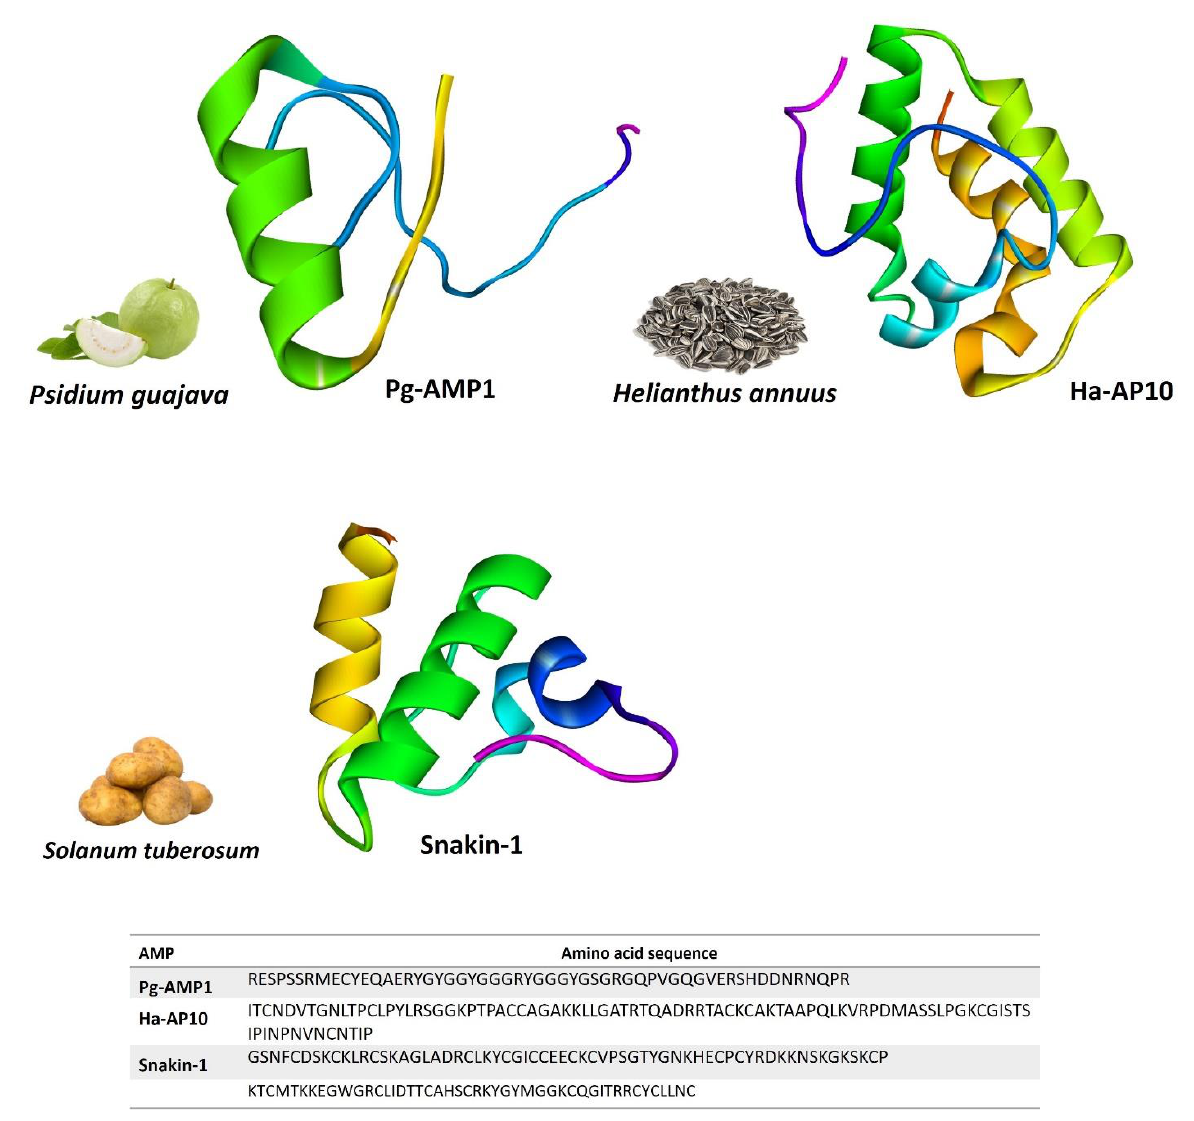
Figure 3. Selected glycine-rich, lipid transfer, and snakin proteins that showed potential antimicrobial activities for food preservation: Pg-AMP1 (predicted in this study), Ha-AP10 (predicted in this study), and snakin-1 (PDB ID: 5E5Q). Predicted structures are modeled via homology modeling using the Swiss model (https://swissmodel.expasy.org accessed on 30 July 2022).